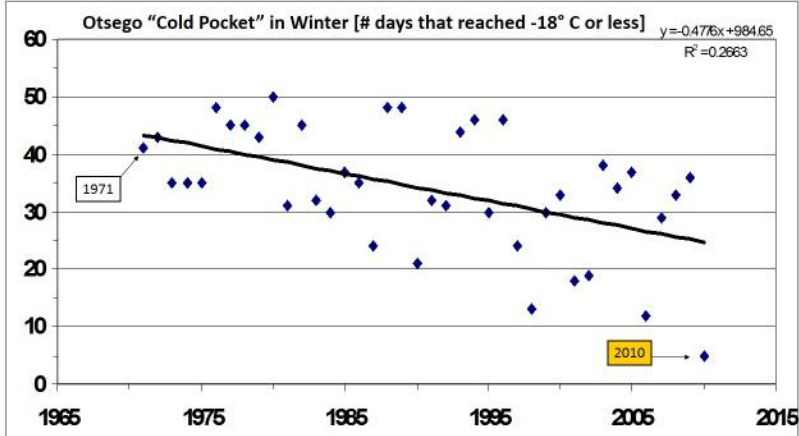
Figure 9. The number of winter days reaching (cid:237)(cid:20)(cid:27)(cid:3) °C (or lower) in the climatic cold pocket [383]. (R² = 0.266, p = 0.01).